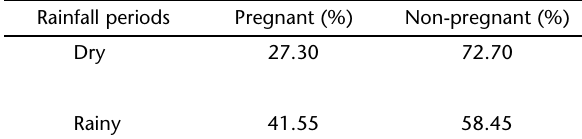
Table II. Abundance of S. nanii in the different intestinal portions of P. argenteus , from the São Francisco River, Três Marias, Minas Gerais, Brazil.